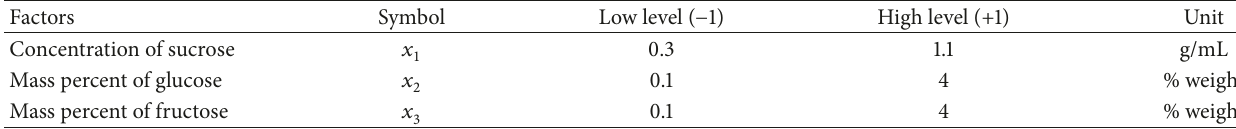
Table 3: The experimental ranges and levels of independent variables.